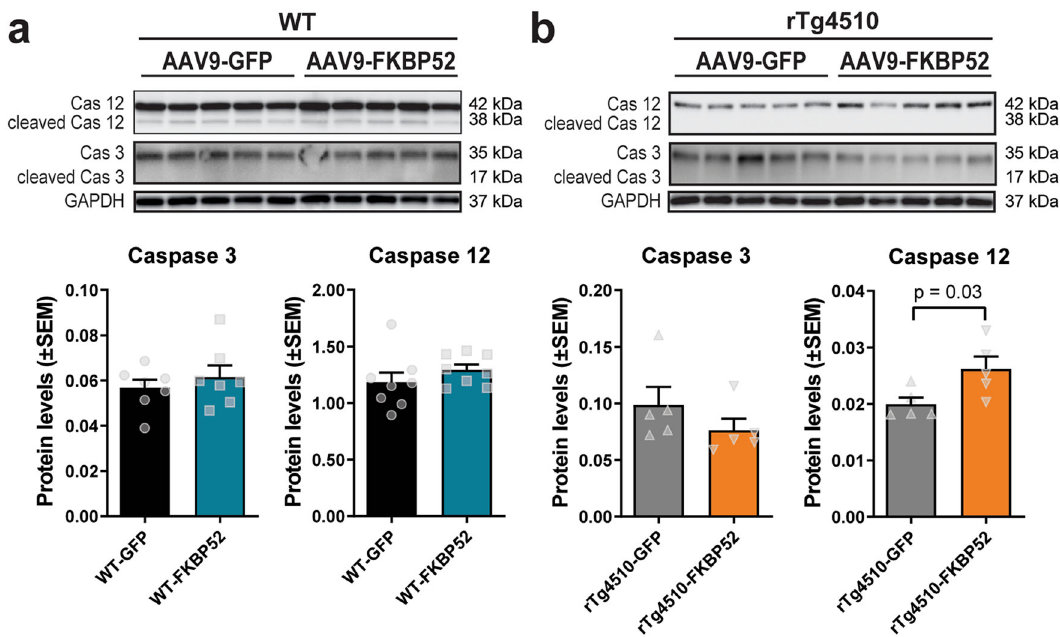
Fig. 9 FKBP52 induces caspase 12 in rTg4510, but not WT, animals. a Caspase 3 and caspase 12 levels in WT mice injected with AAV9-GFP and AAV9-FKBP52. b Quanti fi cation of caspase 3 and caspase 12 in rTg4510 mice receiving hippocampal injections of the same virus. Proteins were normalized to GAPDH. Data were analyzed by Student ’ s t test and represented as standard error of the mean (±SEM). WT-GFP ( n = 8), WT-FKBP52 ( n = 8), rTg4510-GFP ( n = 5), rTg4510-FKBP52 ( n = 5). Cas caspase, kDa kilodalton, AAV9 adeno-associated virus serotype 9, GFP green fl uorescent protein, WT wild-type, GAPDH Glyceraldehyde 3-phosphate